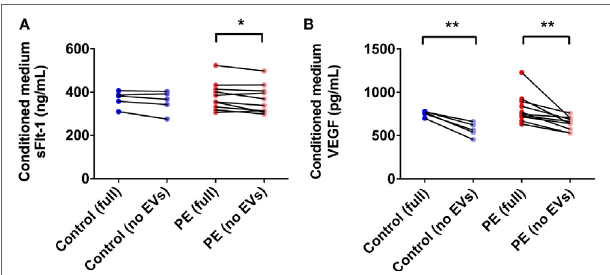
FigUre 7 | Levels of sFlt-1 and vascular endothelial growth factor (VEGF) measured in the conditioned medium from preeclamptic (PE) and normotensive placentae, before and after ultracentrifugation. Conditioned media were collected from normotensive (control) and PE placentae (full). Then, half of the conditioned medium was ultracentrifuged at 100,000 × g for 1 h to deplete EVs (no EVs) and the levels of sFlt-1 (a) and VEGF (B) in the no EVs and full conditioned media samples were quantified by sandwich ELISA (* p < 0.05, ** p < 0.01, unpaired t -test between control and PE data, paired t -test within control or PE